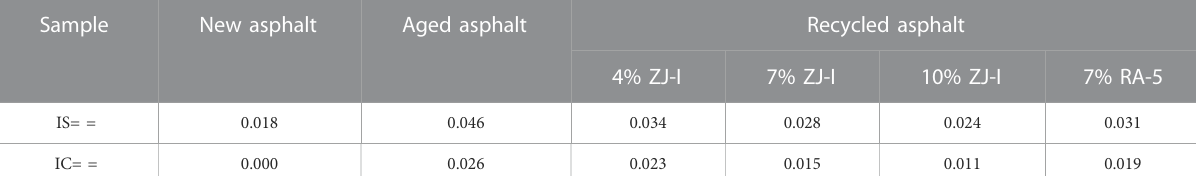
TABLE 13 I C=O and I S=O index data of the four asphalts.